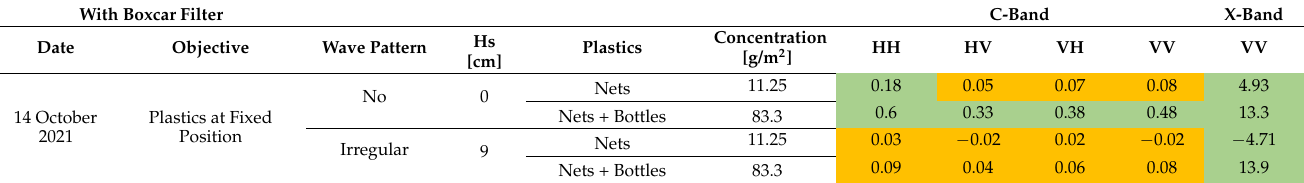
Table 6. Results of statistical analysis Undertaken on 1st campaign measurements with the use of a boxcar filter. Values filling the table are the results of the difference of the reference measurement